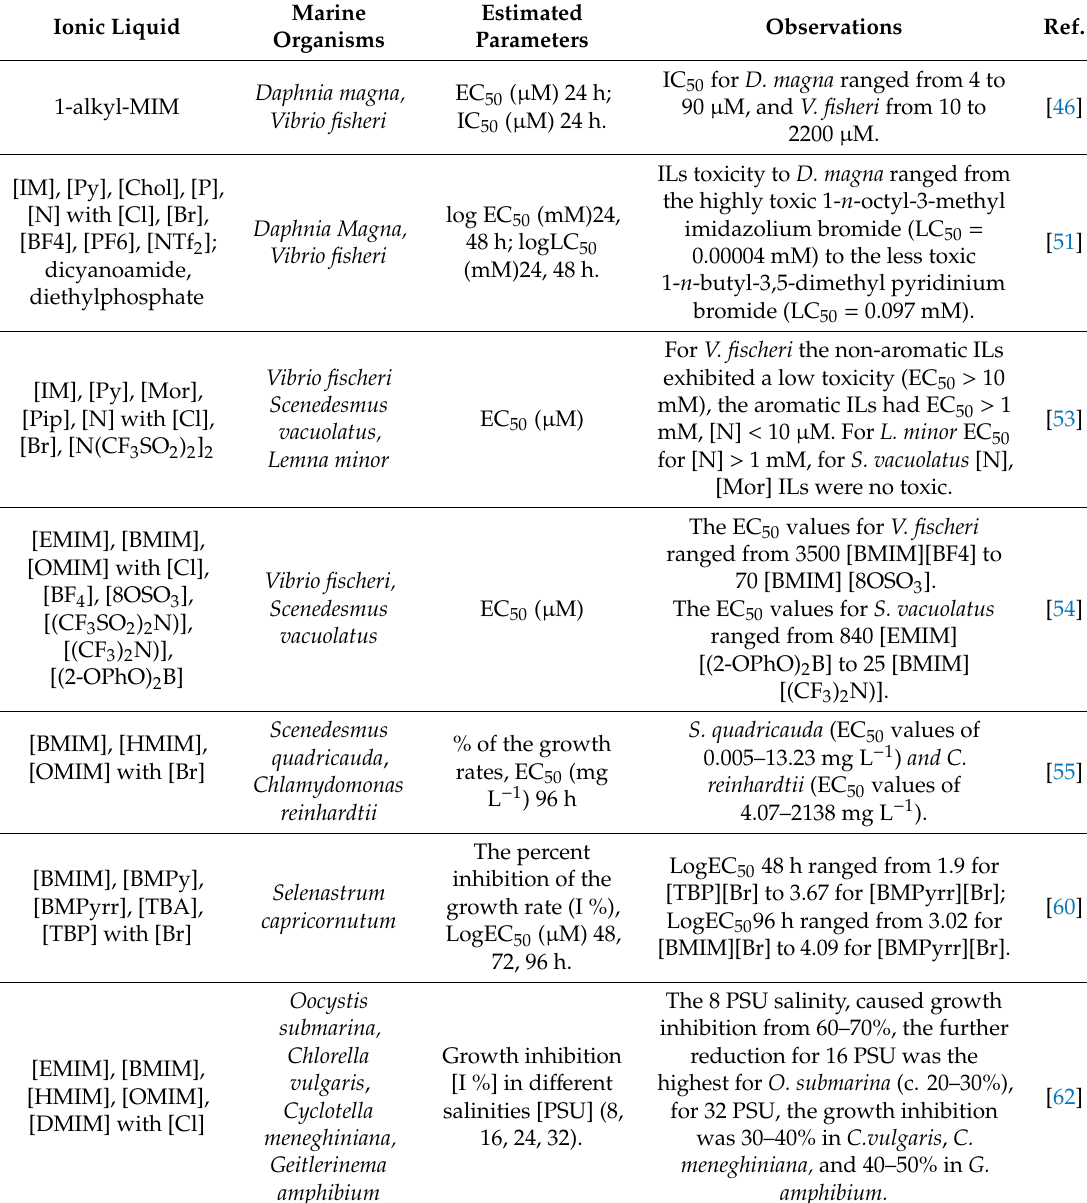
Table 2. Toxicity of ionic liquids to aquatic